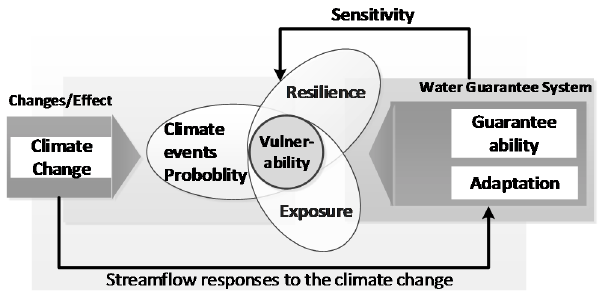
Figure 2. Illustration of the core concepts of water resource vulnerability coupled with water stress probability, exposure, resilience and elasticity of water resources to climate change. The paper assesses how exposure and resilience to climate events determine impacts; evaluates the influence of climate change in contributing to water stress, as well as the exposure and resilience of water resources; and considers the role of guarantee ability and adaptation to climate change in reducing exposure and water scarcity to climate change.